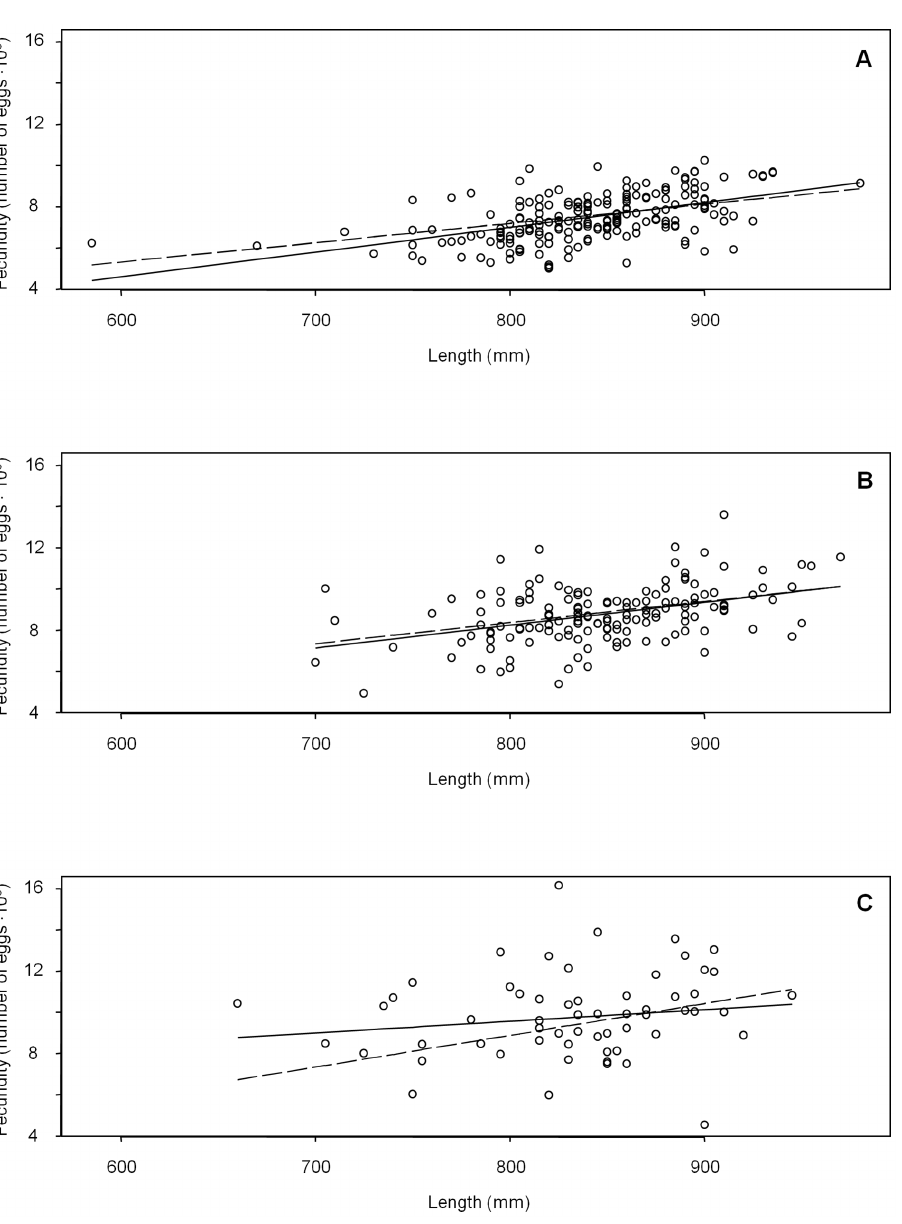
Figure 4. Estimated linear regression models of mean Yukon River Chinook salmon fecundity versus fish length for three reporting groups, (A) Upper, (B) Middle, and (C) Lower, based on the Bayesian mixture model (solid line) and individual assignments (dashed line).